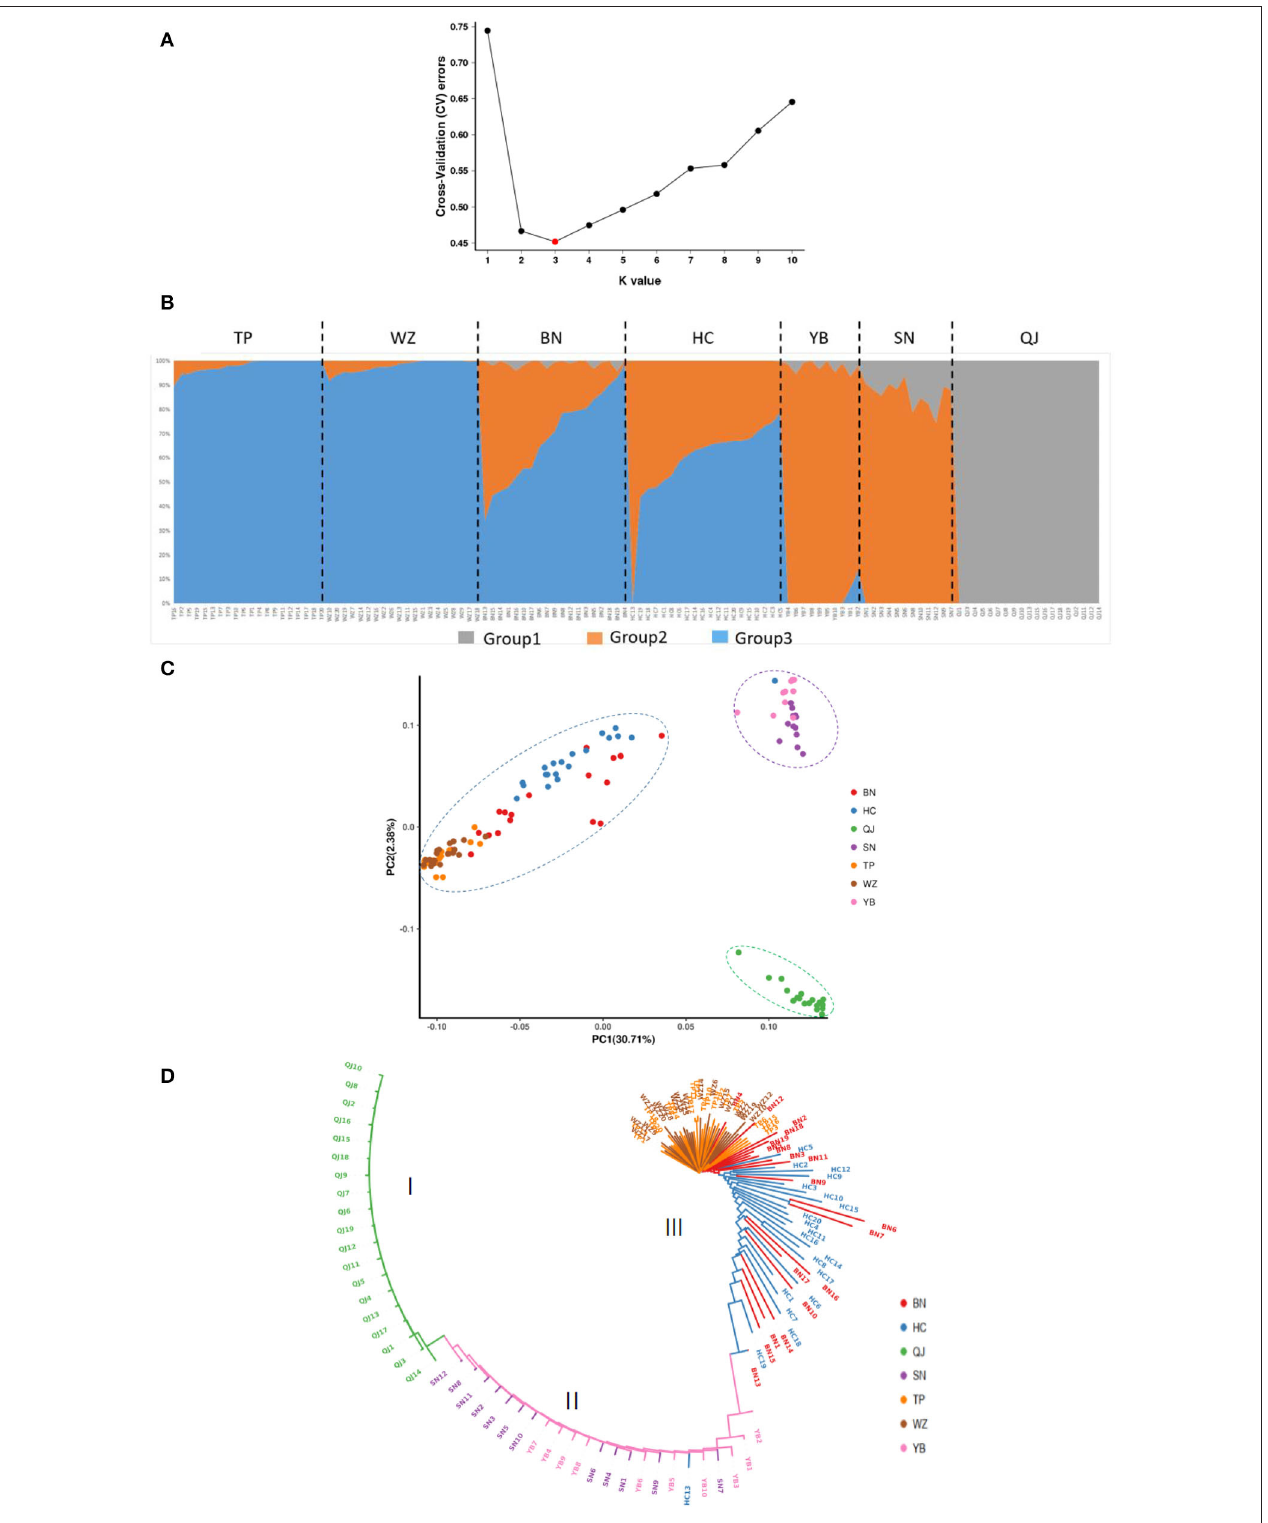
FIGURE 2 | Genetic structure of seven Saurogobio dabryi ( S. dabryi ) populations based on SNP markers. (A) The optimal number of clusters was determined by minimized cross-validated error rate. (B) Population structure ( K = 3) of all individuals. Different colors represent the probability of an individual belonging to different genetic groups. (C) PCA plots of every individual. (D) ML phylogenetic tree. Cluster I included all QJ individuals, cluster II included all SN and YB individuals and one HC individual, and cluster III included all BN, WZ, and TP individuals and the rest of the HC individuals.